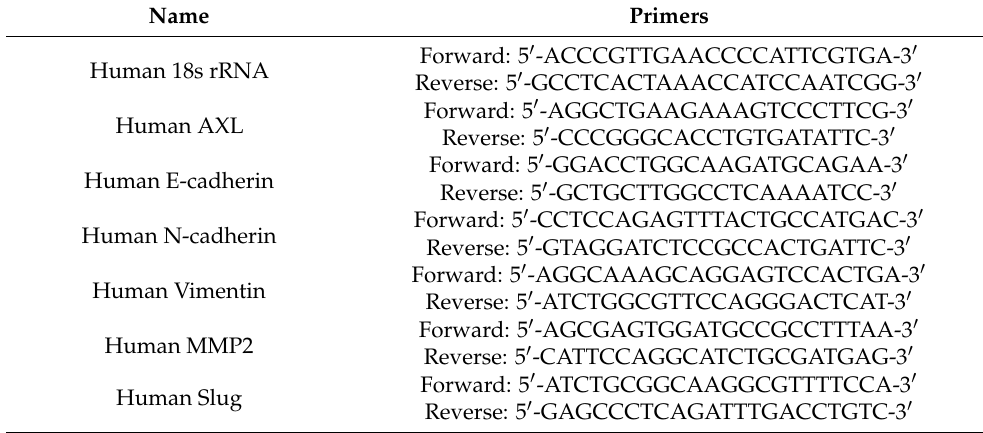
Table 1. Primer sequences for targeted